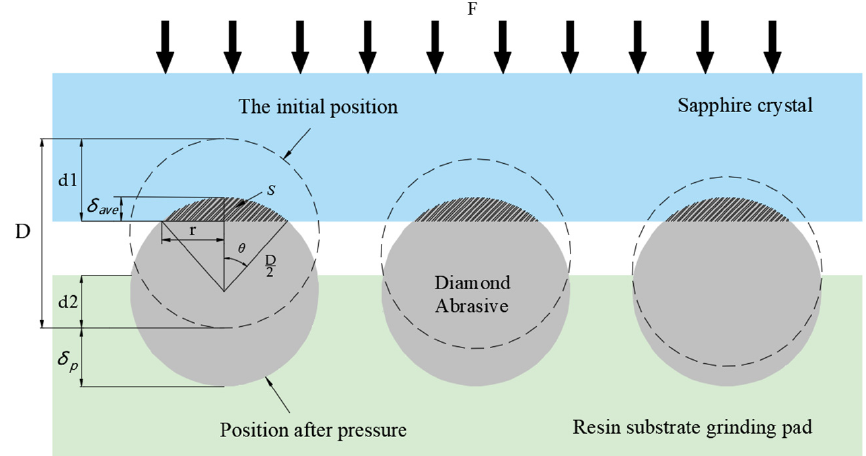
Figure 1. Schematic diagram of abrasive grains cutting into sapphire.